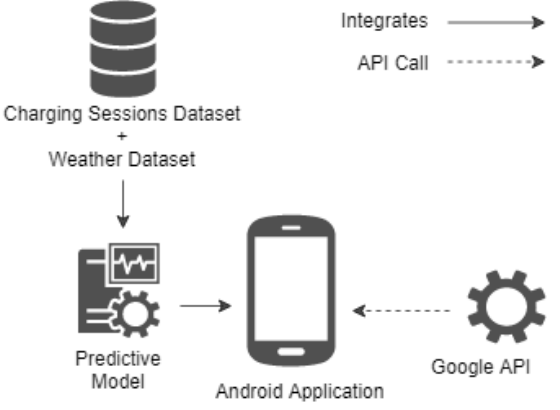
Figure 1. Conceptual Model Diagram.